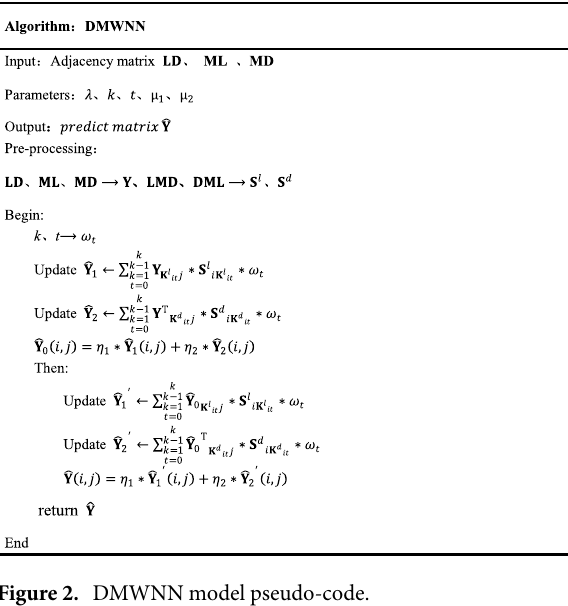
Figure 2. DMWNN model pseudo-code.